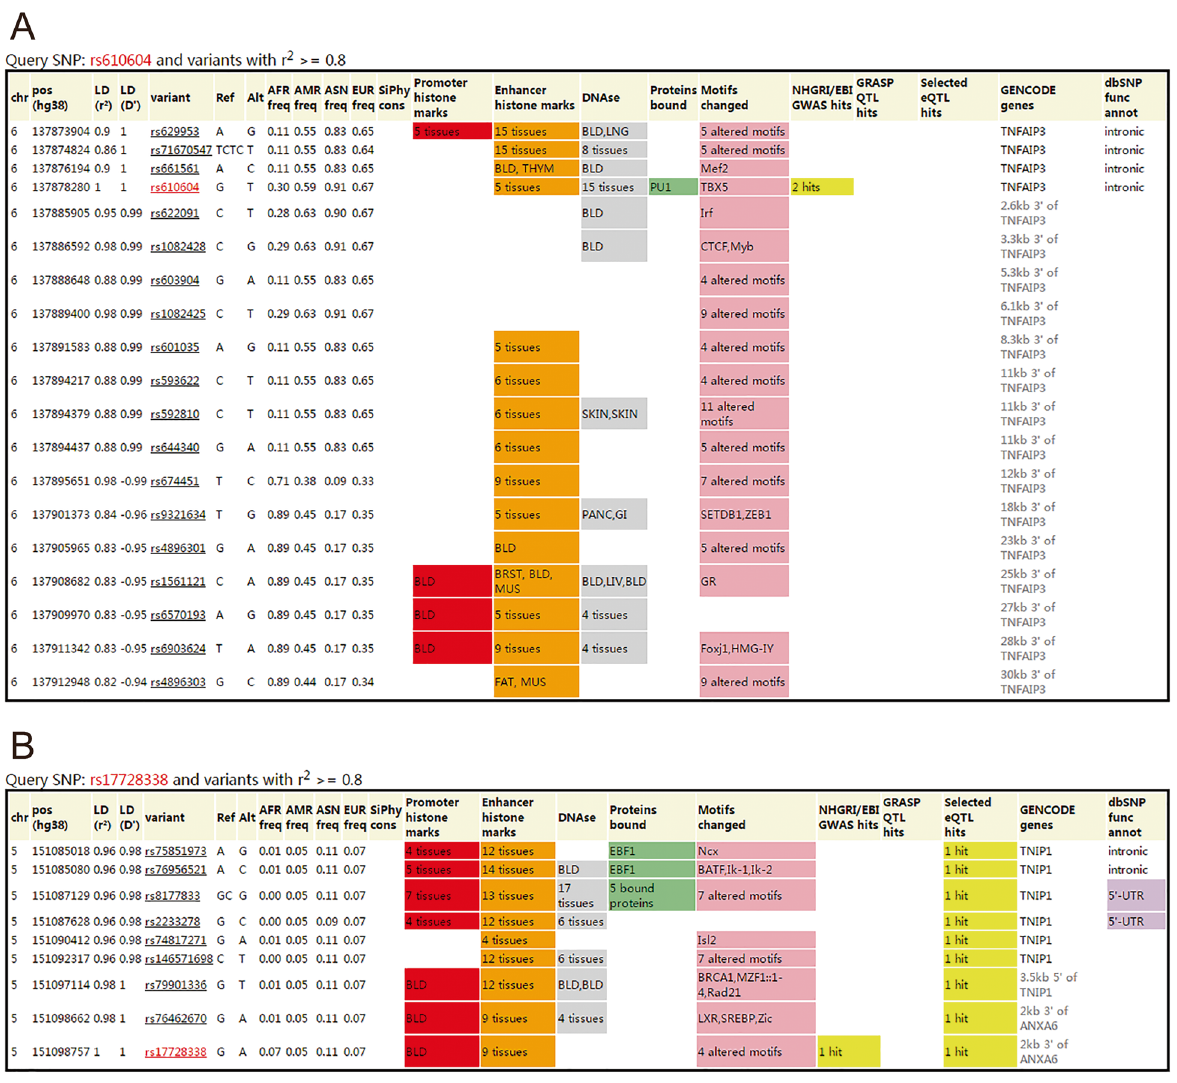
Fig. 9 HaploReg view of rs610604 in TNFAIP3 and rs17728338 in TNIP1 gene using HaploReg version 4.1 (http://pubs.broadinstitute.org/ mammals/haploreg/haploreg.php). a rs610604; b